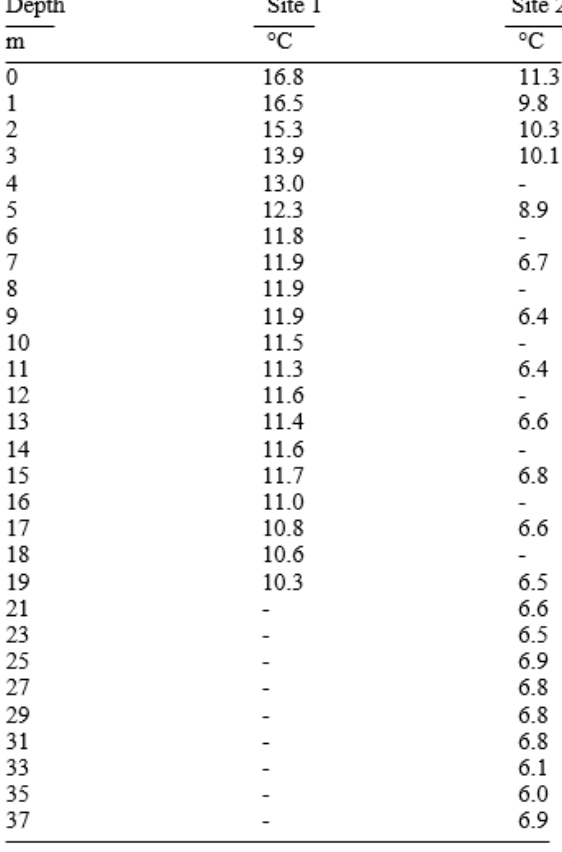
Table 1. Average monthly temperatures of soil mass in September for sites 1 and